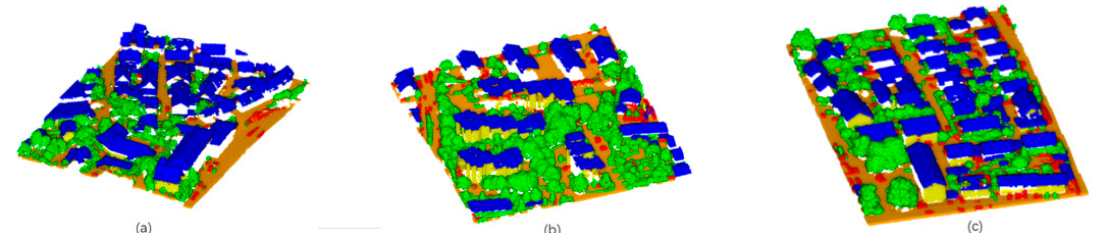
Figure 6. Multiple primitives to split point clouds. ( a ) Planar segments and semantic segments. ( b ) Segments and points.